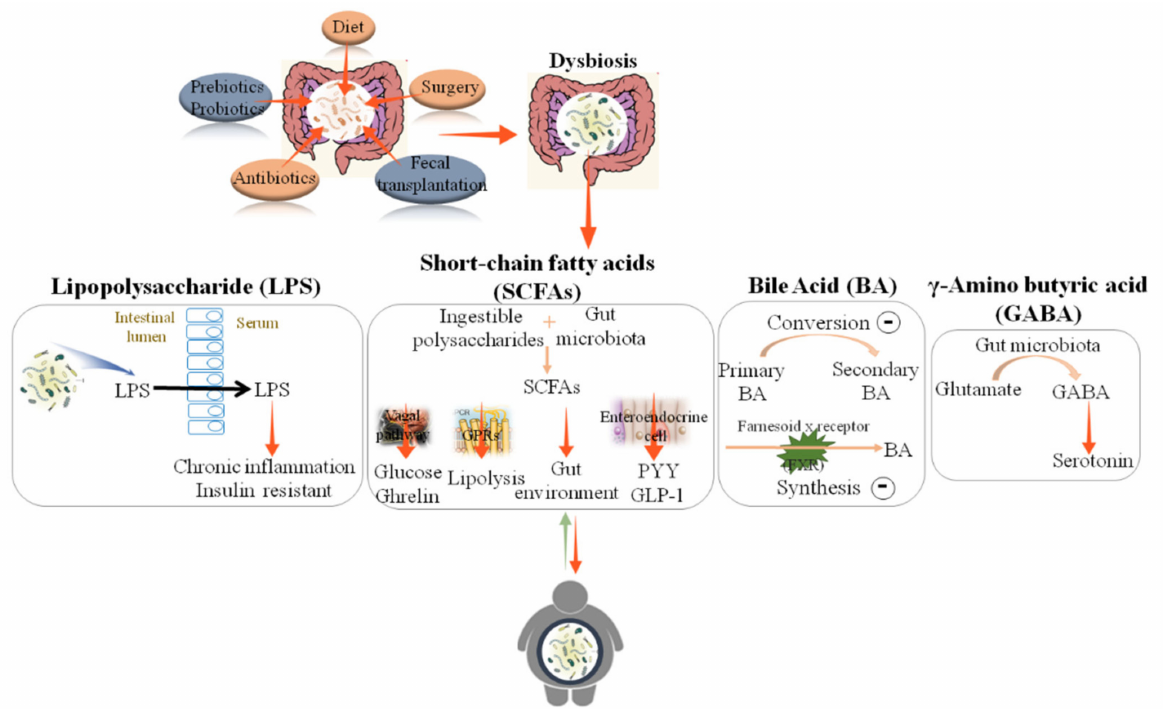
Figure 3. Interaction of altered gut microbiota and downstream metabolic effects influencing